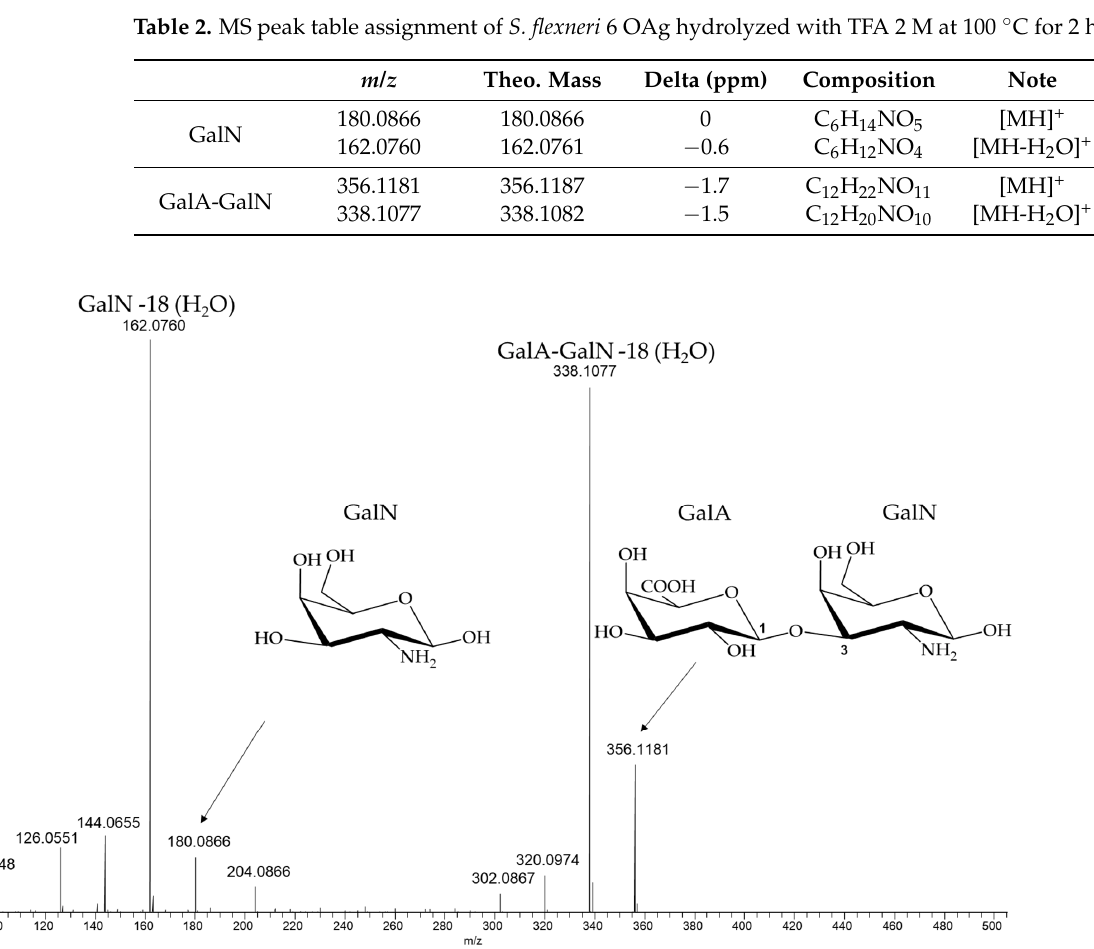
Figure 4. HPAEC-PAD chromatogram of the dimer GalA-GalN obtained after hydrolysis of S. flexneri 6 OAg, eluted in CarboPac PA1 column with NaOH 400 mM as eluent.